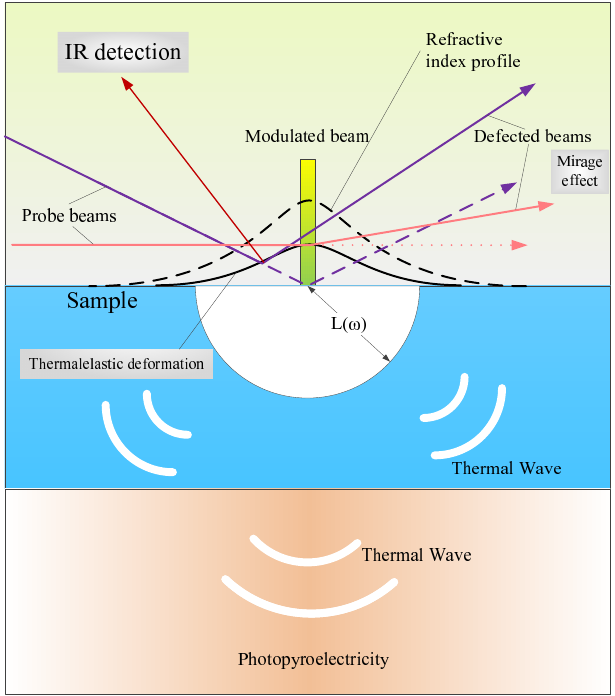
Figure 22. The photothermal effects in a sample illuminated by the pump beam.